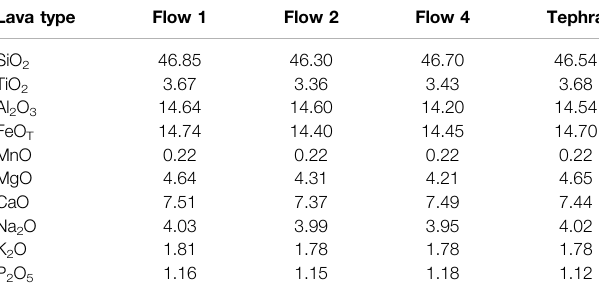
TABLE 2 | Major element analyses of some Tseax lavas. Data from Le Moigne et al. (2022). Lava